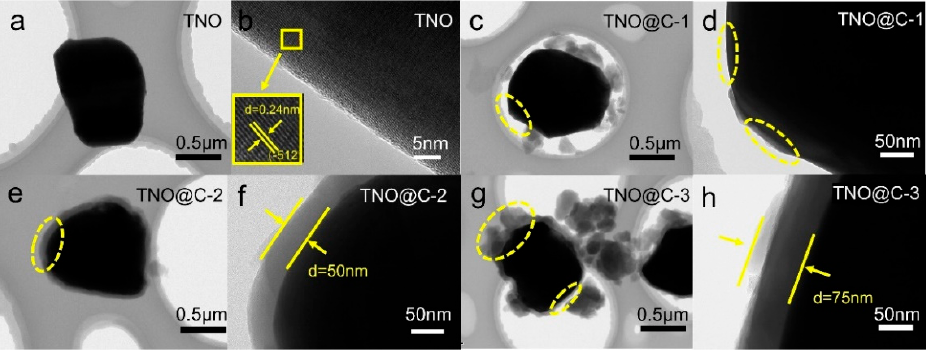
Figure 4. TEM images of ( a , b ) TNO ( c , d ) TNO@C-1, ( e , f ) TNO@C-2 and ( g , h ) TNO@C-3. Cyclic voltammetry (CV) measurements were performed on TNO and TNO@C